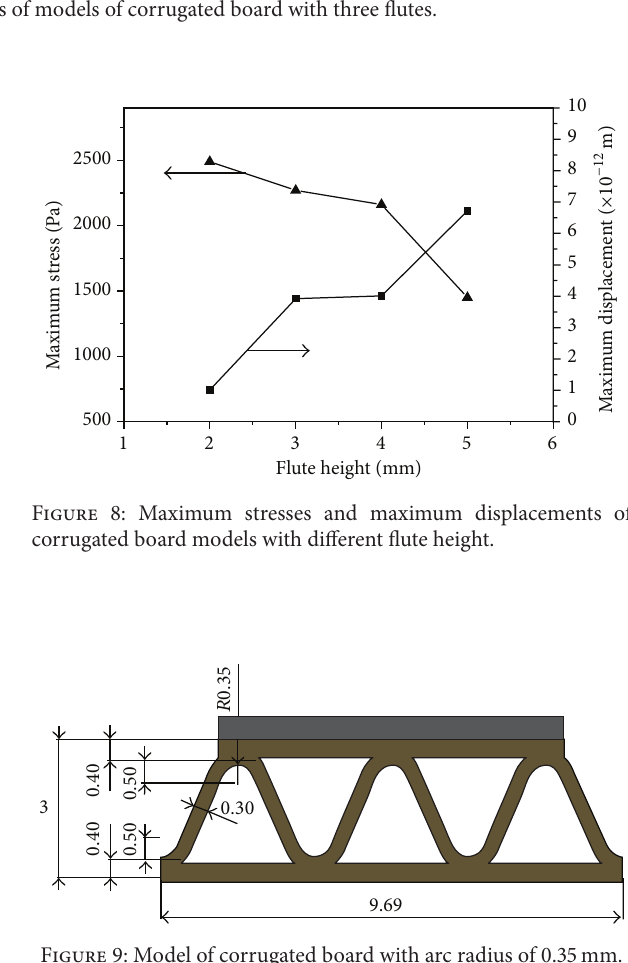
Figure 9: Model of corrugated board with arc radius of 0.35